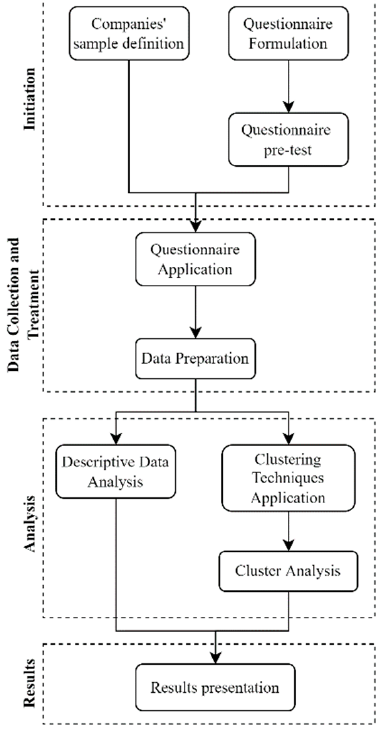
Figure 1. Methodological workflow of this study.